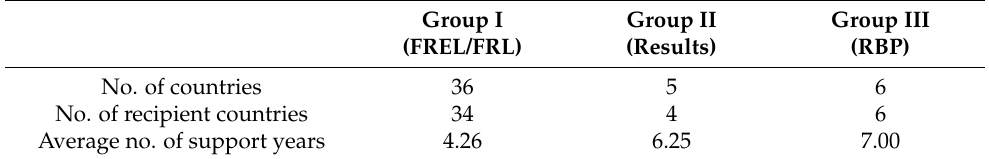
Table 3. Duration of international support received by each